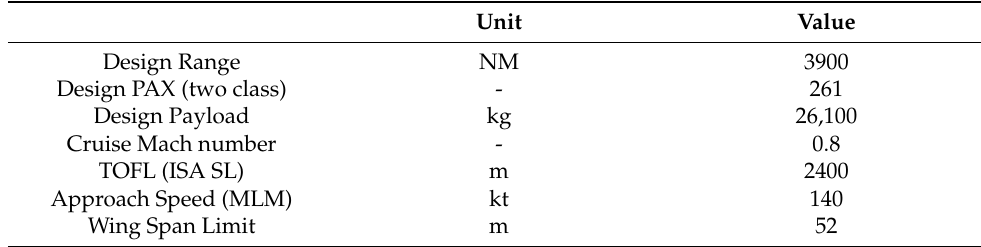
Table 3. Top Level Aircraft